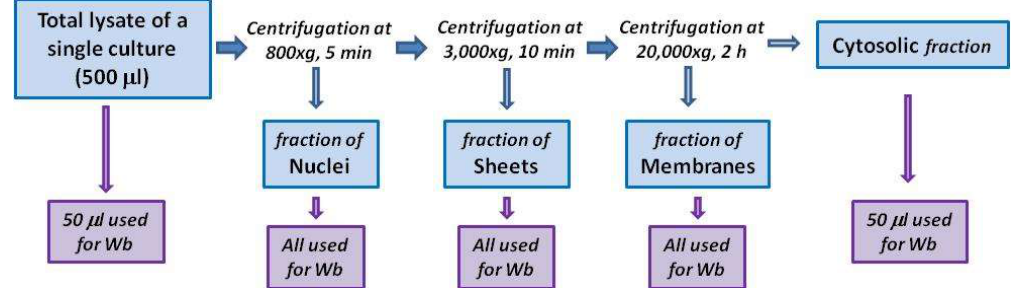
Figure 7. Scheme of the fractionating protocol, starting from 500 μL of total lysate; pellets, representing nuclear, sheet, and membrane fractions, were recovered and loaded onto an SDS-page for Western blot (Wb) analysis. Western blot was also conducted on aliquots (50 μL) of cytosol and total